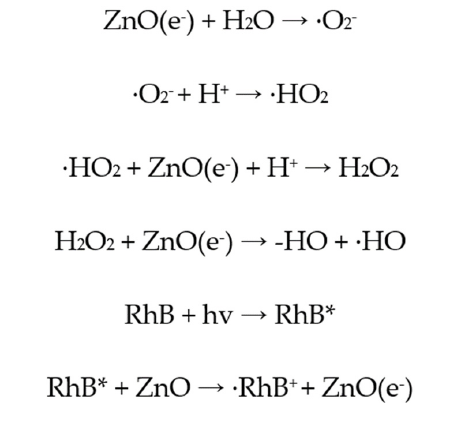
Figure 16. The main steps of the heterogeneous photocatalytic degradation of RhB by ZnO.